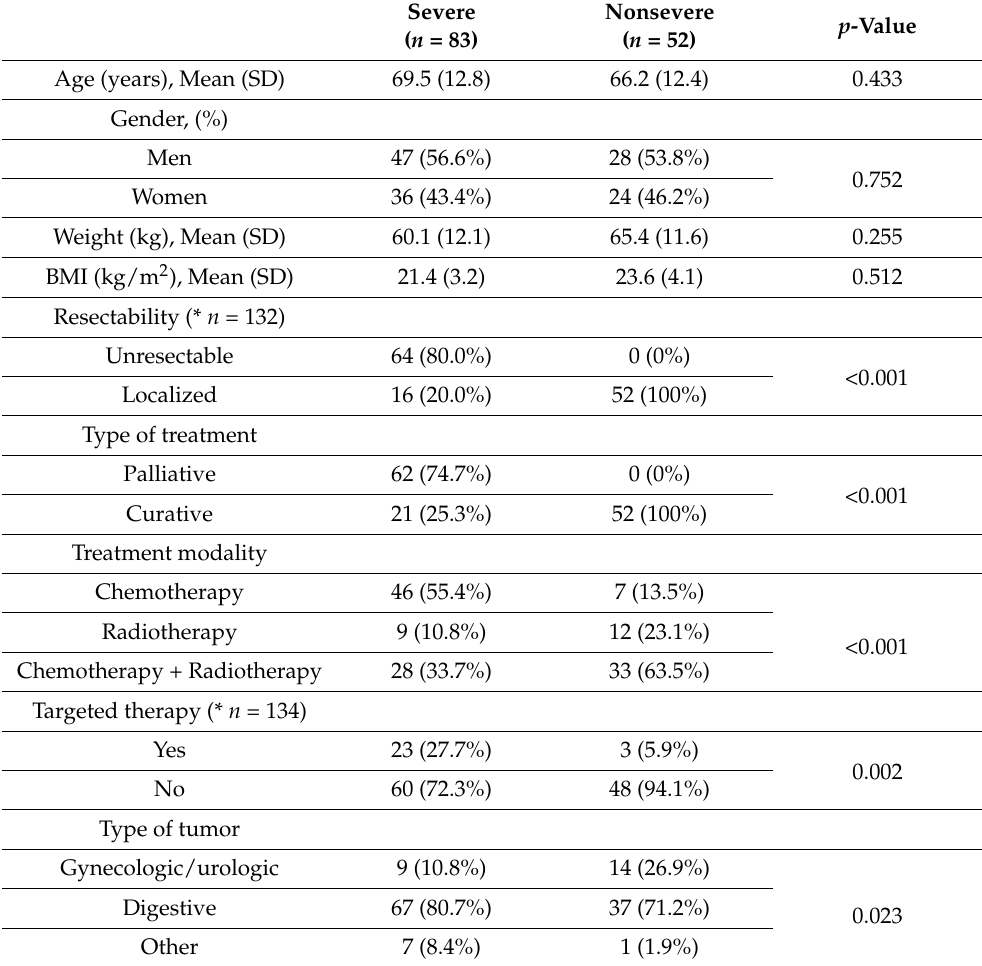
Table 1. Demographic and clinical characteristics of study